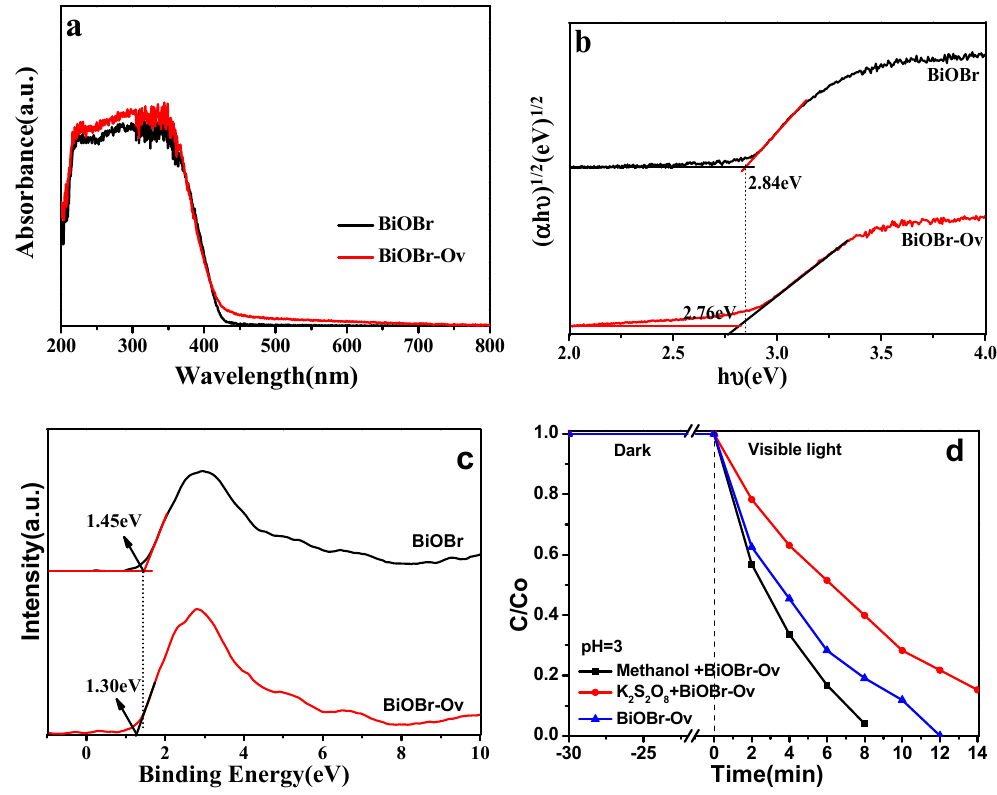
Figure 8. ( a ) UV-Vis diffuse reflectance spectra, ( b ) the plots of (ah ν ) 1/2 vs. h ν and ( c ) valence band X-ray photoelectron spectroscopy (VB-XPS) spectra of BiOBr and BiOBr-Ov, ( d ) photogenerated carriers trapping for photoreduction of Cr(VI).